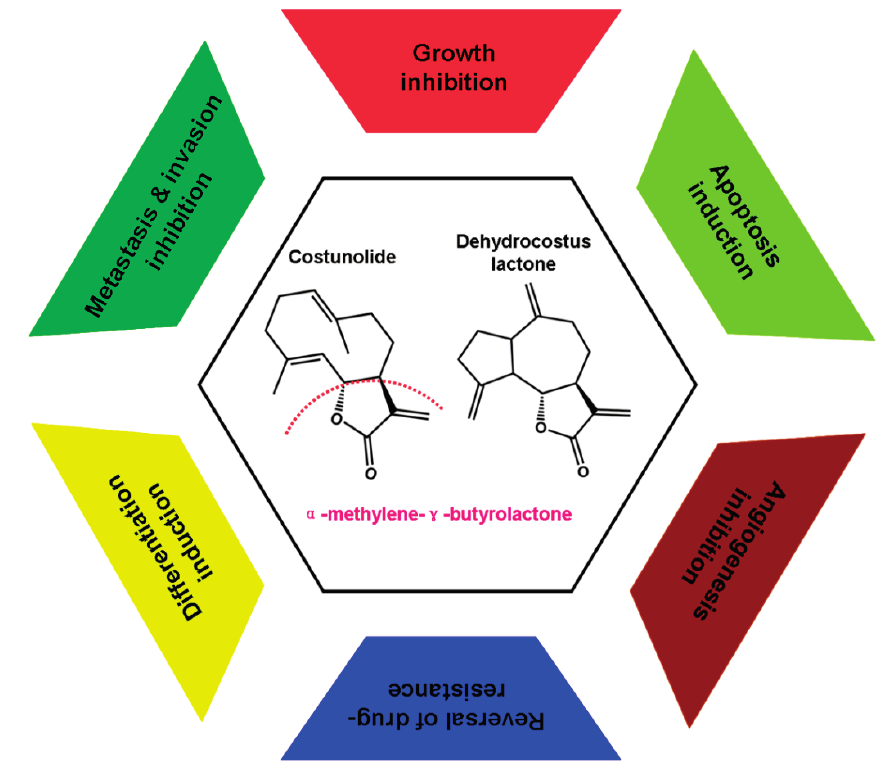
Figure 1. Chemical structure and possible anti-cancer mechanisms of Costunolide (CE) and dehydrocostuslactone (DE). CE (C 15 H 20 O 2 ) and DE (C 15 H 18 O 2 ) could exert their